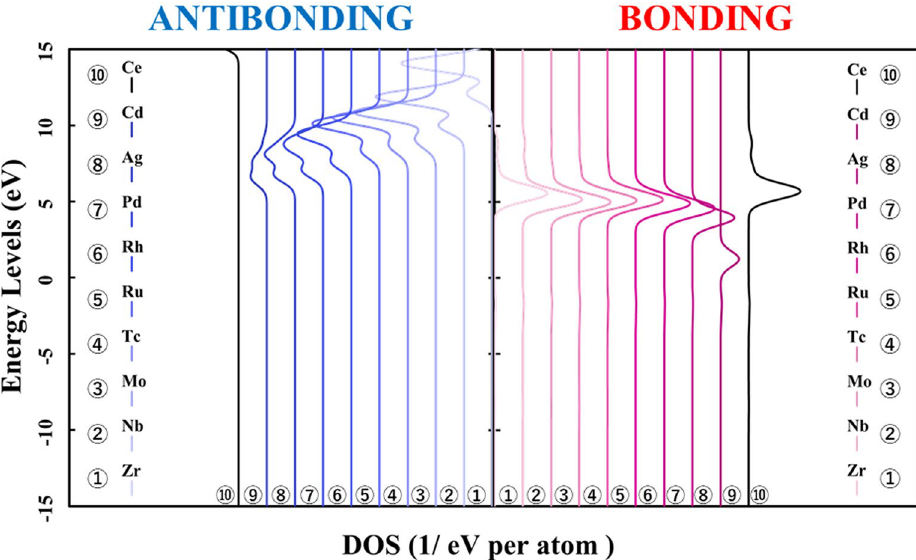
Figure 10. Energy levels of the bond composition between the metal 4d orbitals and the oxygen 2p orbitals are based on the reference level as the vacuum level in the M@Ce 12 O 8 36+ cluster model (M = Zr, Nb, Mo, Tc, Ru, Rh, Pd, Ag, Cd). The bond composition between the metal 5d orbitals and the oxygen 2p orbitals are in the undoped ceria. The bonding and antibonding orbital components are on the right and left sides, respectively.